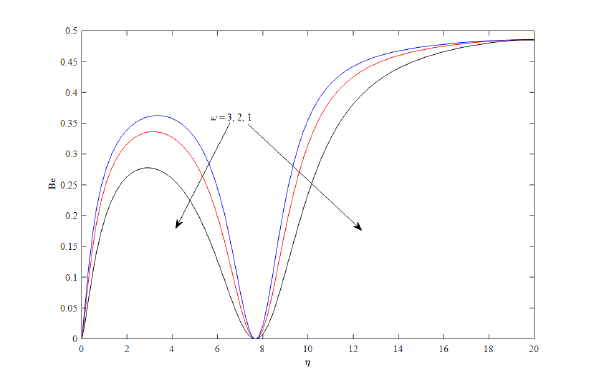
Fig. 11 Bejan number with varying ω when Br = 1 , Q = 1 , M = 1 , X = 2 , Pr = 2 , S = 0 . 01 , K = 0 . 95 .